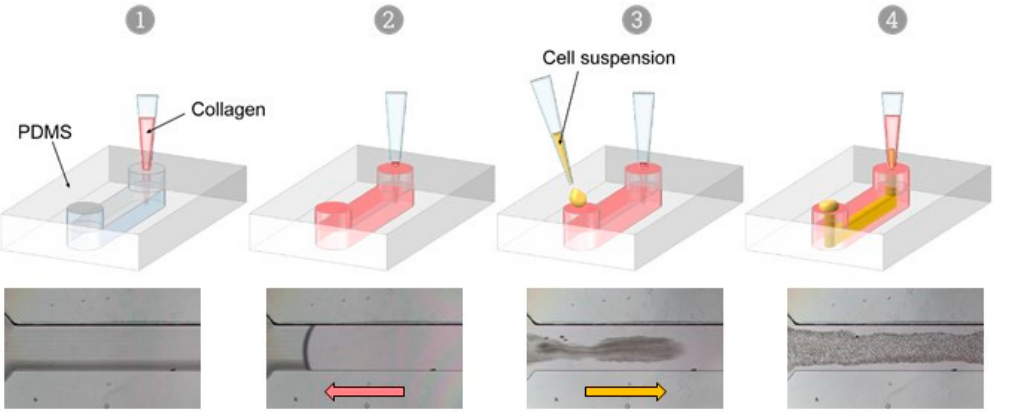
Figure 3. Viscous finger patterning approach. Successive steps of the viscous finger patterning technique, top; principle, bottom; phase-contrast images of VFP applied in a channel loaded with collagen ( 1 , 2 ), then with a cell suspension in culture medium which progresses through the collagen solution ( 3 , 4 ) in a finger-like